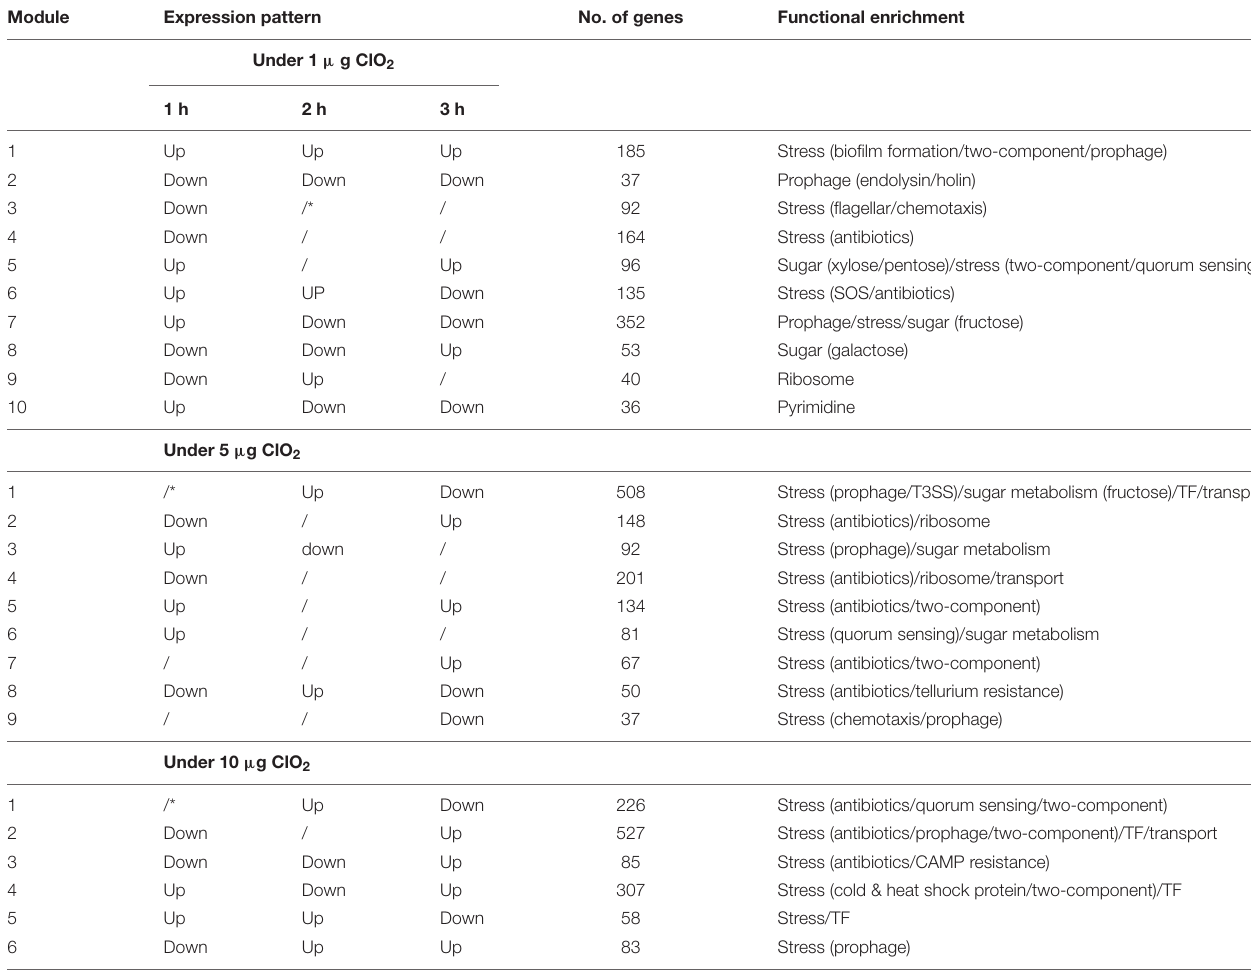
TABLE 1 | Gene functional enrichment of E. coli expression regulatory modules during the exposure to 1 µ g, 5 µ g, and 10 µ g ClO 2 per gram of ripe fruits. Module Expression pattern No. of genes Functional